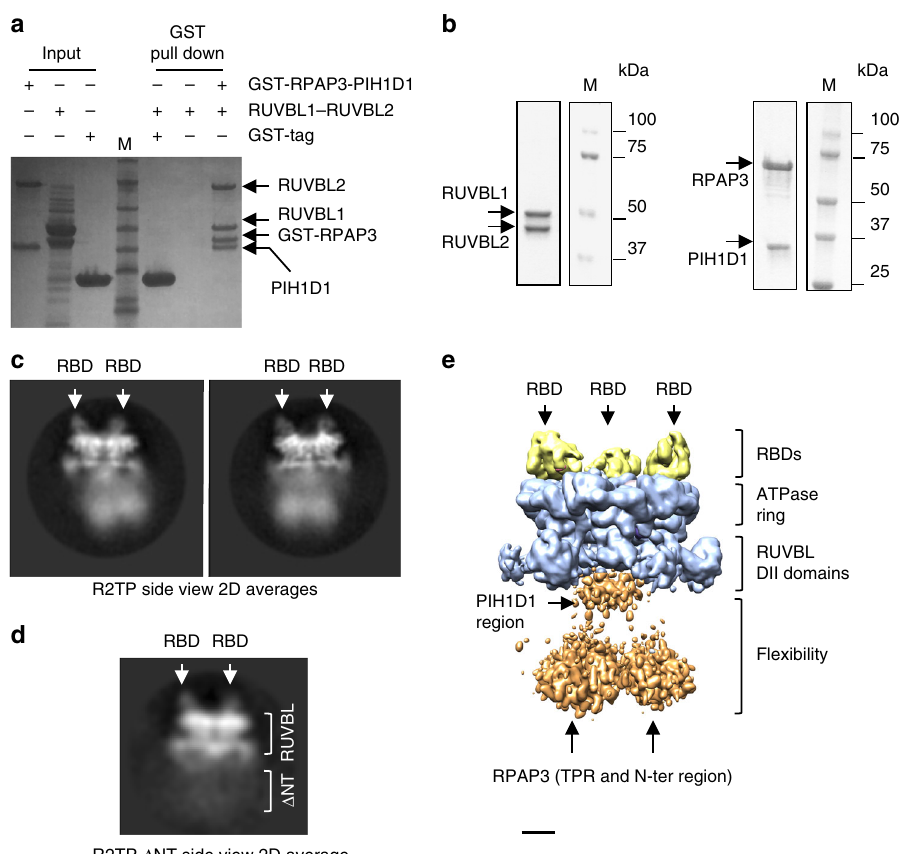
Fig. 3 Cryo-EM imaging of the R2TP complex. a Pull-down experiments showing the in vitro reconstitution of R2TP. M indicates molecular weight markers. b Puri fi cation of RUVBL1 – RUVBL2 and PIH1D1 – RPAP3 sub-complexes, used for the reconstitution of R2TP for cryo-EM. M indicates molecular weight markers. c Two representative side view averages of R2TP. RUVBL1 – RUVBL2 rings are decorated by the RBD at the top (labeled with white arrows). A blurred and very fl exible region locates at the bottom of the ring. d A representative side view average of R2TP reconstructed using the RPAP3 – Δ NT – PIH1D1 sub-complex and RUVBL1 – RUVBL2. Flexible regions at the bottom end of R2TP disappear when the N-terminal half of RPAP3 is removed, but dodecameric RUVBL1 – RUVBL2 is disrupted. e 3D structure of R2TP obtained applying 3-fold symmetry. RBDs are bound to RUVBL1 – RUVBL2 but the fl exible regions in the complex are not resolved. Scale bar, 2.5